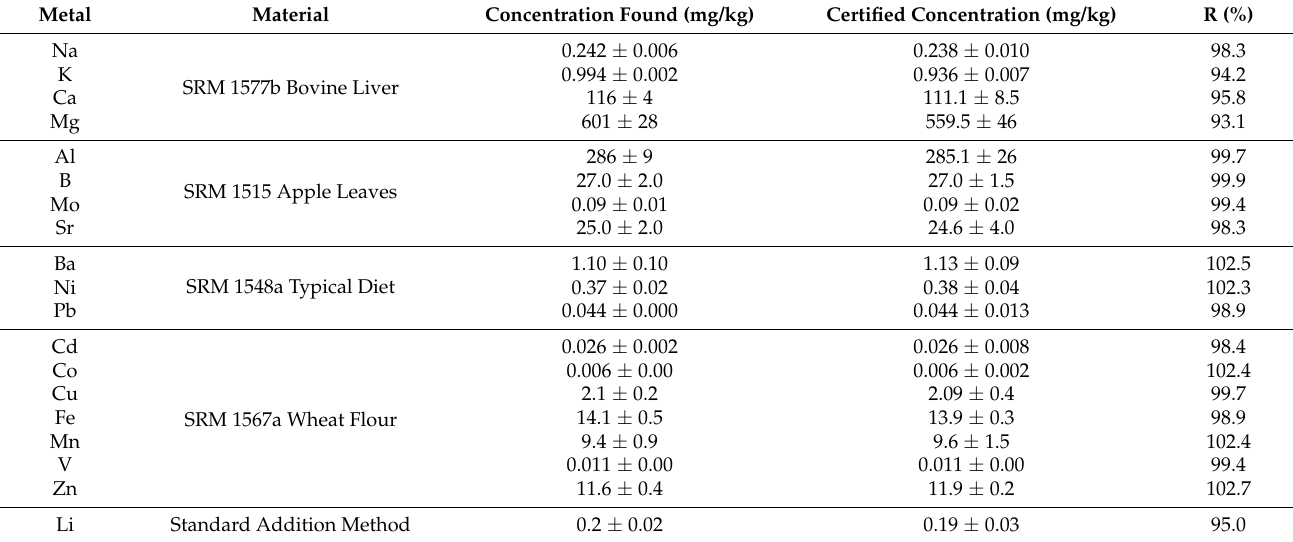
Table 4. Recovery percentage found for the reference materials